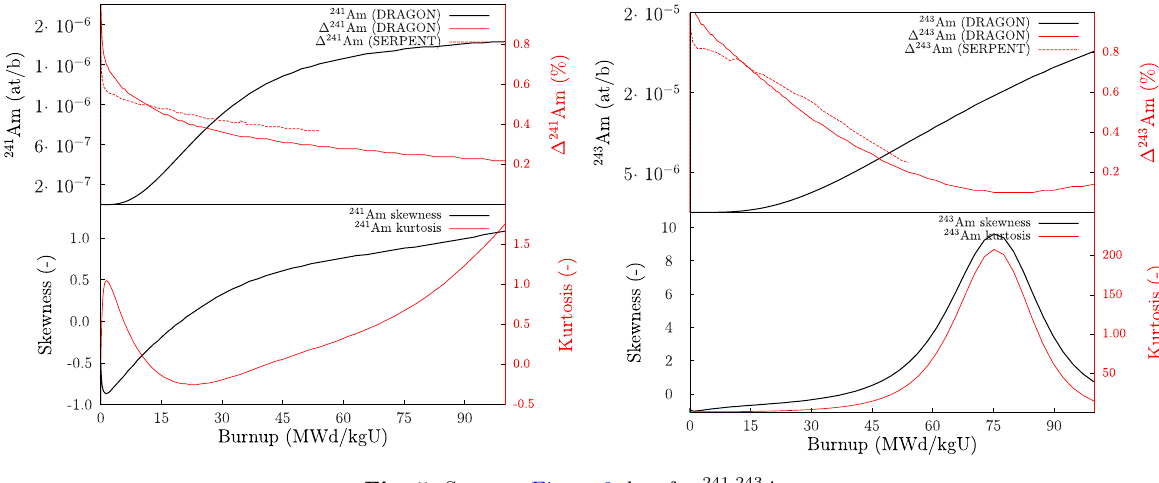
Fig. 5. Same as Figure 3, but for 241 , 243 Am. Table 1. Uncertainties in isotopic concentrations ( ∆ C) in% (1 σ ) due to thermal scattering data of H in H 2 O at 50 MWd/kgU obtained from SERPENT calculations.